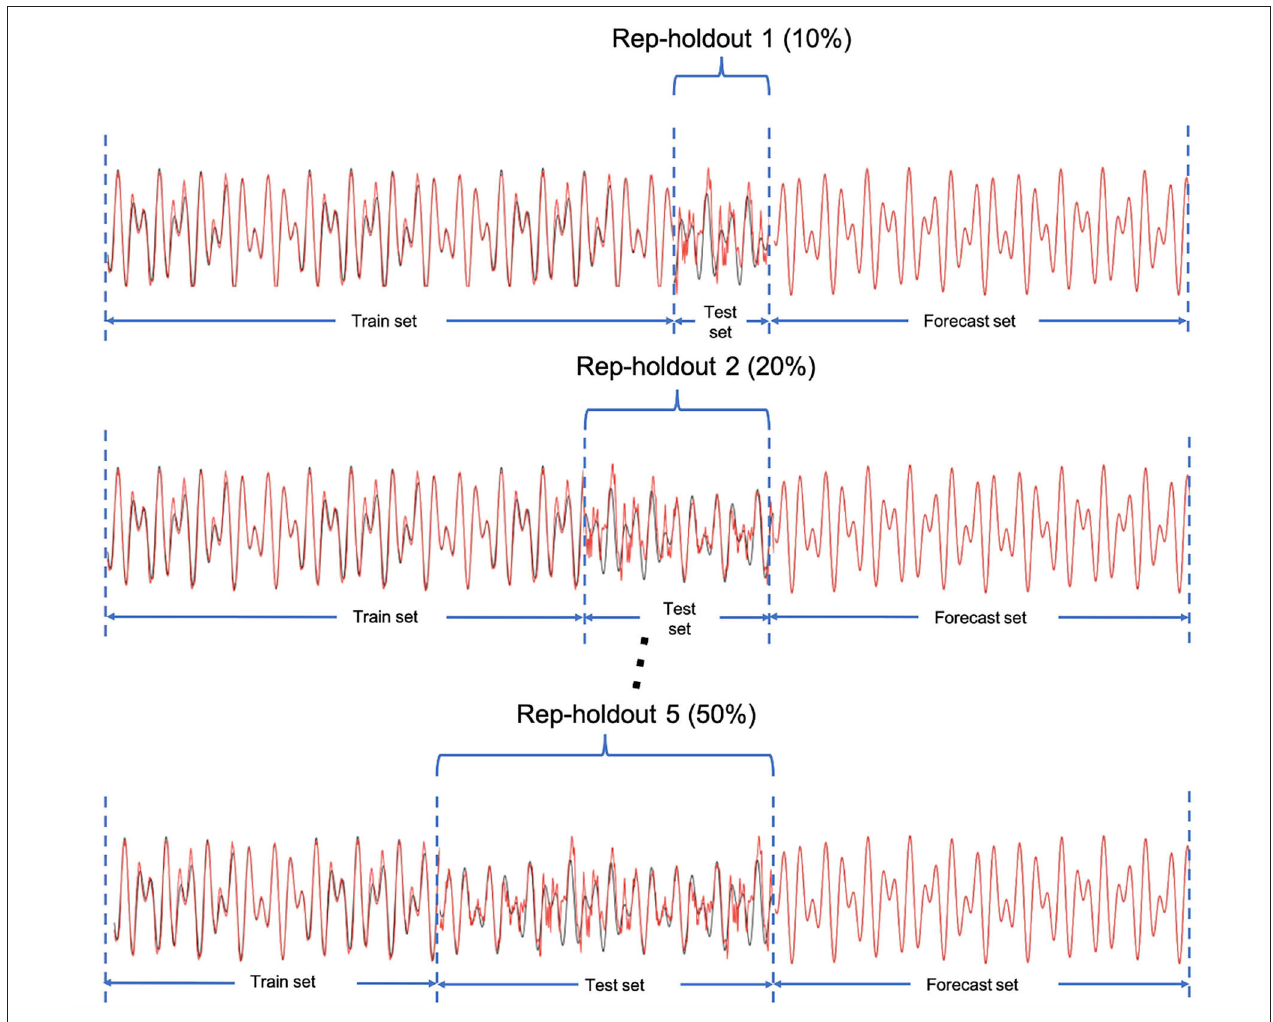
FIGURE 2 | The rep-holdout strategy for model training and validation. The X axis is the time points. series data into training and testing sets by ascending time